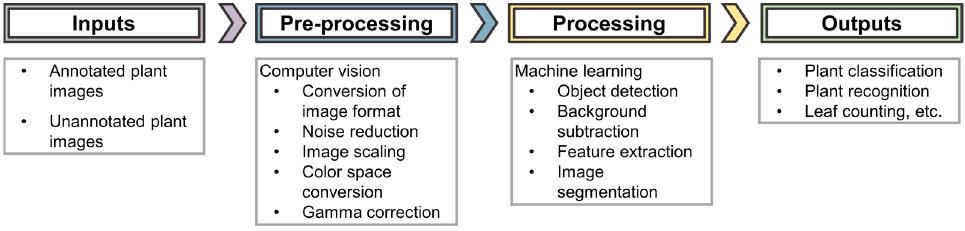
Figure 2. AI workflow for image